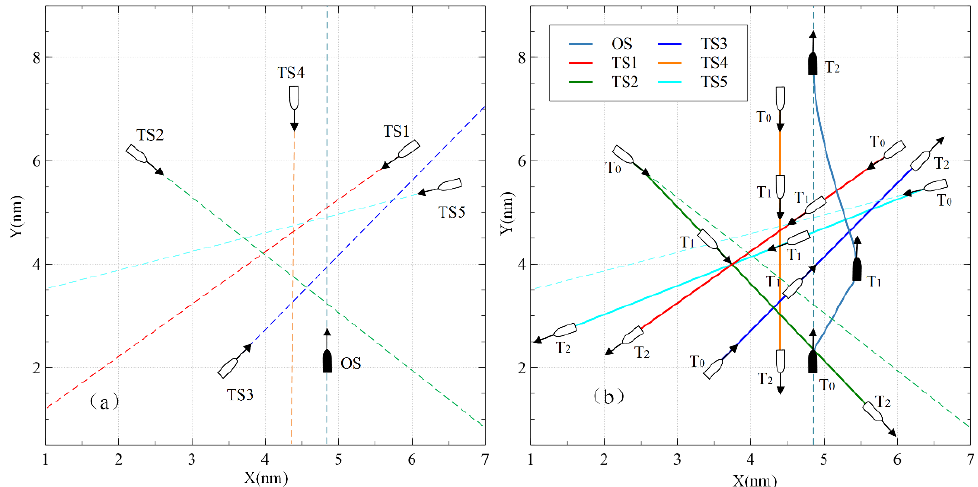
Figure 12. The ships’ trajectories under six-ship encounter situation: ( a ) initial positions and paths; ( b ) trajectories of six ships.